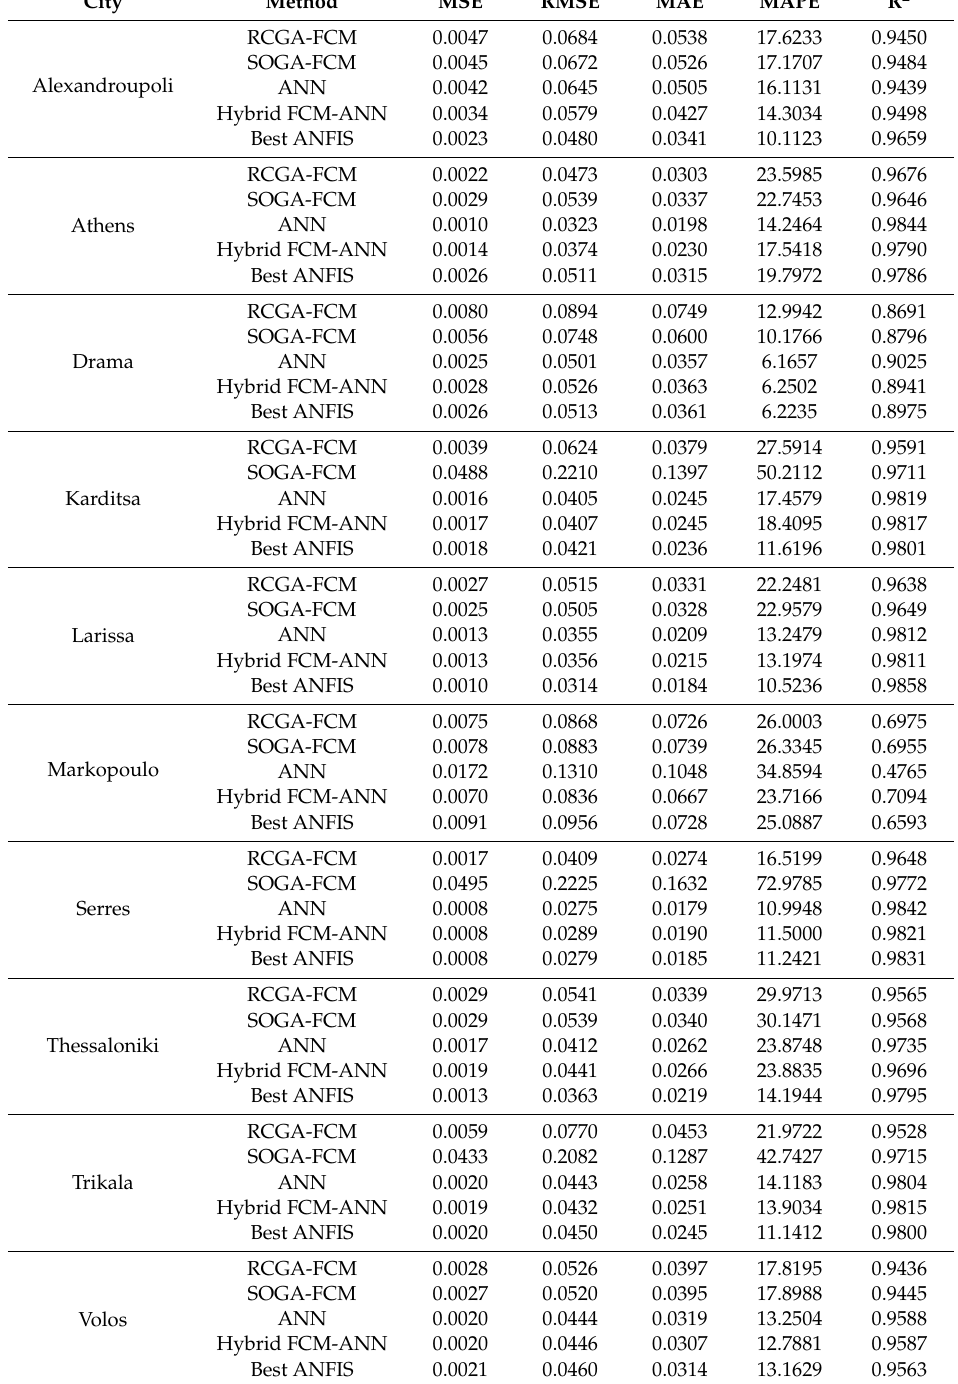
Table 7. Comparison results among the artificial neural network (ANN), fuzzy cognitive map (FCM), hybrid FCM-ANN and best ANFIS architectures of each